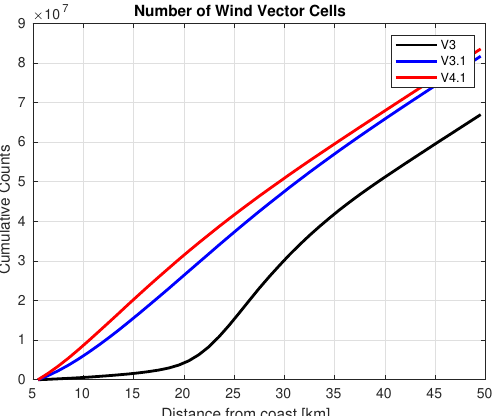
Figure 9. Cumulative number of wind vector cells as a function of distance from coast.